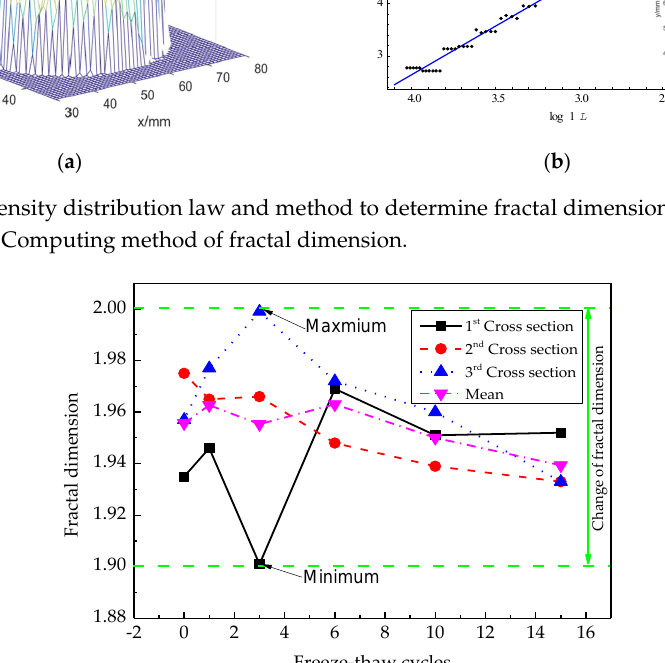
Figure 9. The law for the change of fractal dimension on each cross-section.